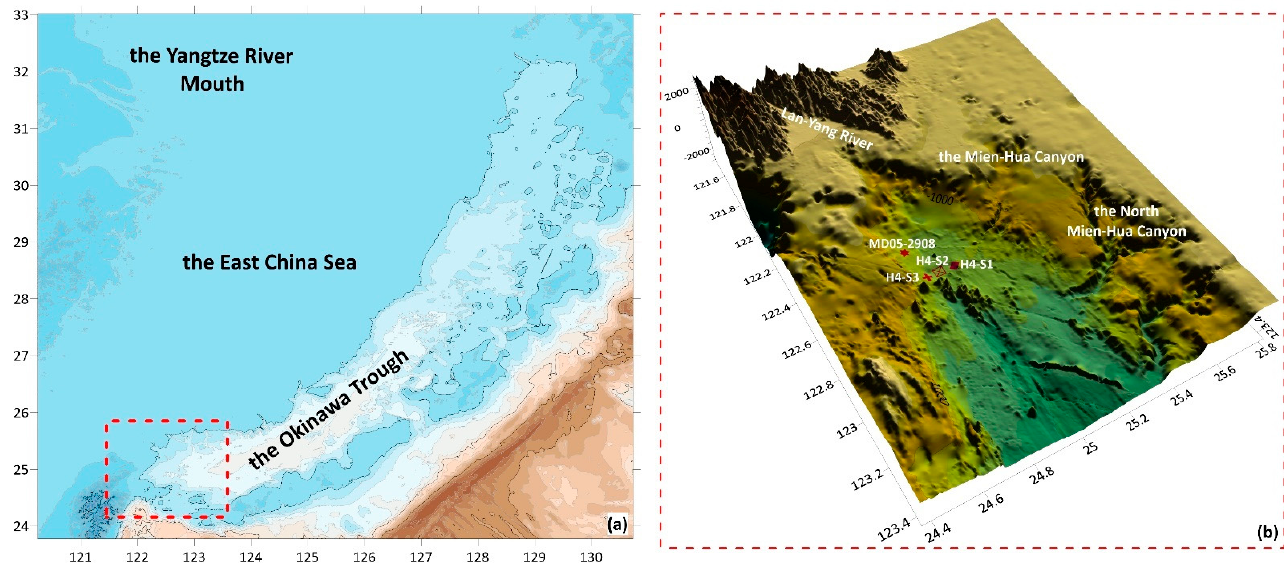
Figure 1. Map of the study area showing the location of H4-S2 and other cores ( a , b ); Topographic data comes from https://www.gebco.net/ (accessed on 7th August, 2021). The specific location of this research is within the red dotted line.